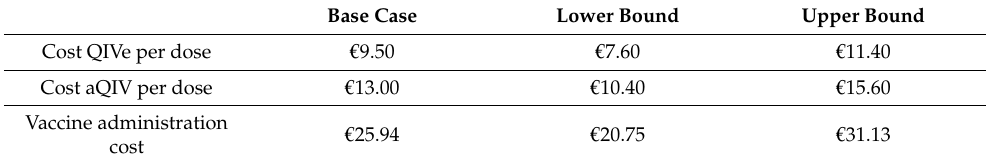
Table A7. Lower and upper bounds for unit resource costs in DSA.